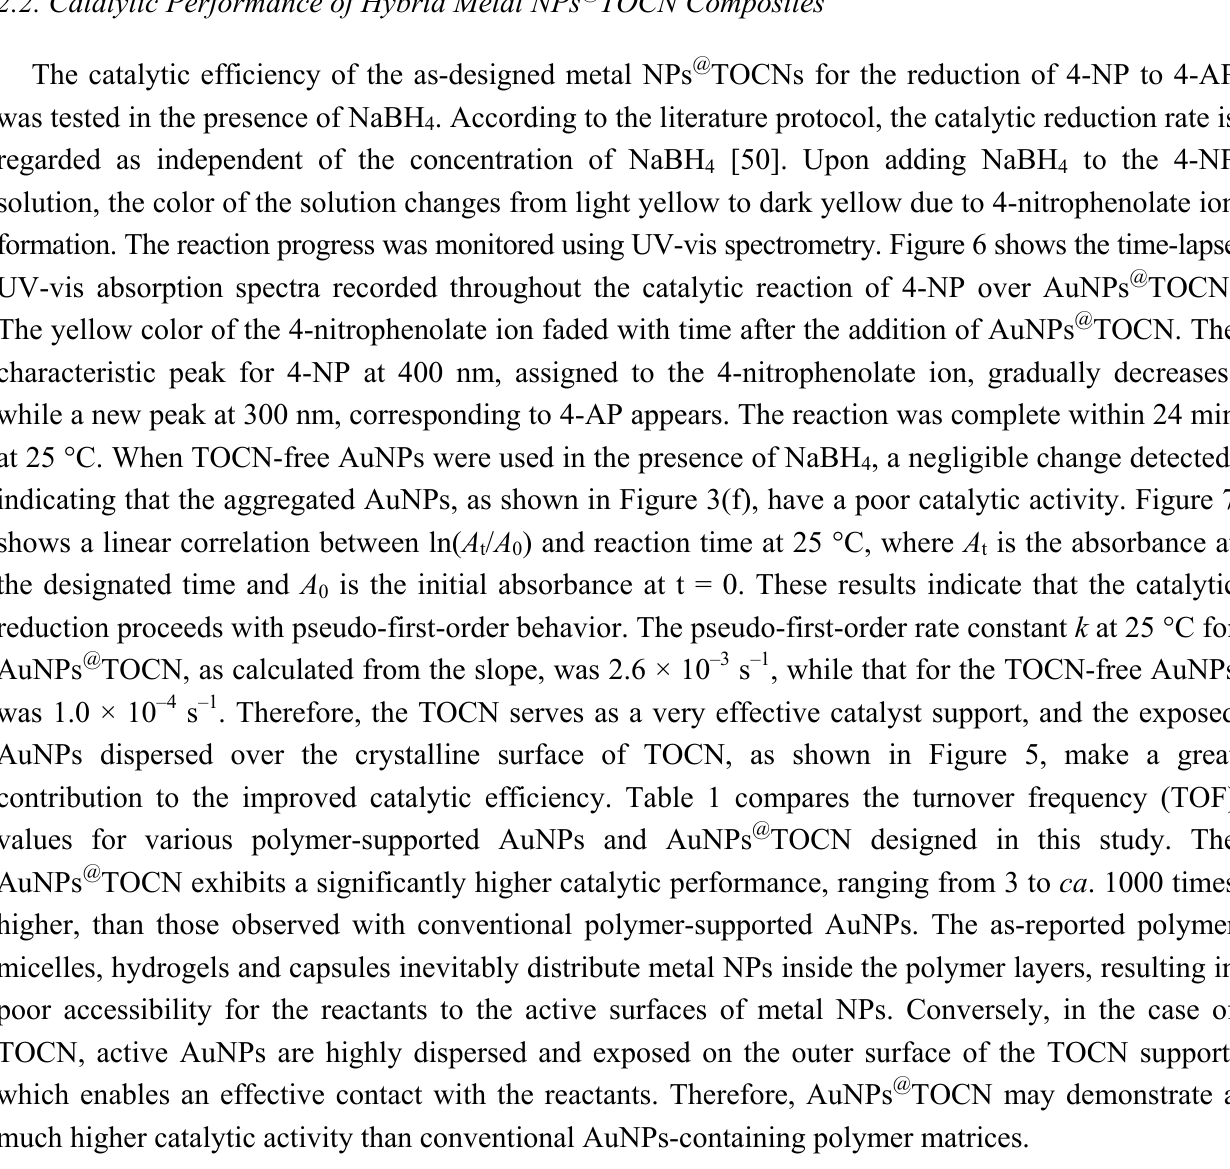
Figure 6. UV-vis absorption spectra variations throughout the catalytic reduction of 4-NP over AuNPs @